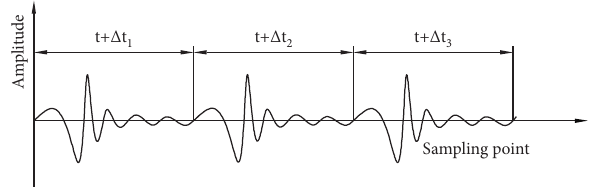
Figure 2: Schematicdiagramofthequasiperiodicsignal. t istheaverage period and Δ t 1 , Δ t 2 , and Δ t 3 are the period deviations, respectively.